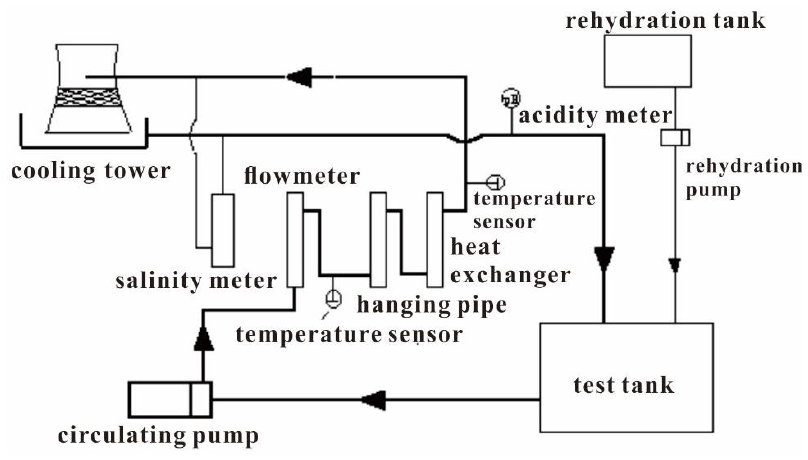
Figure 2. Flow chart of the dynamic scale-inhibition simulation test.